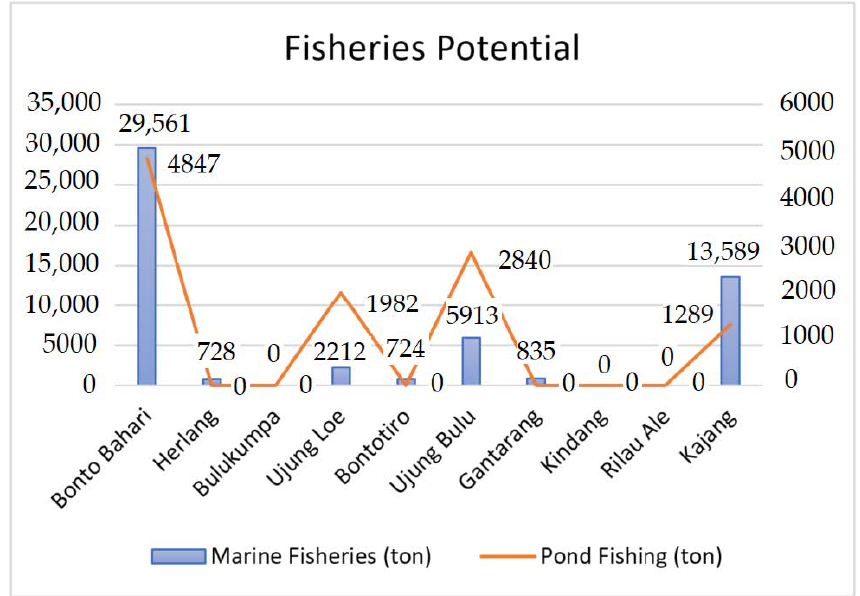
Figure 4. Production of Fisheries Products in Bulukumba Regency. Source: Reference [29].